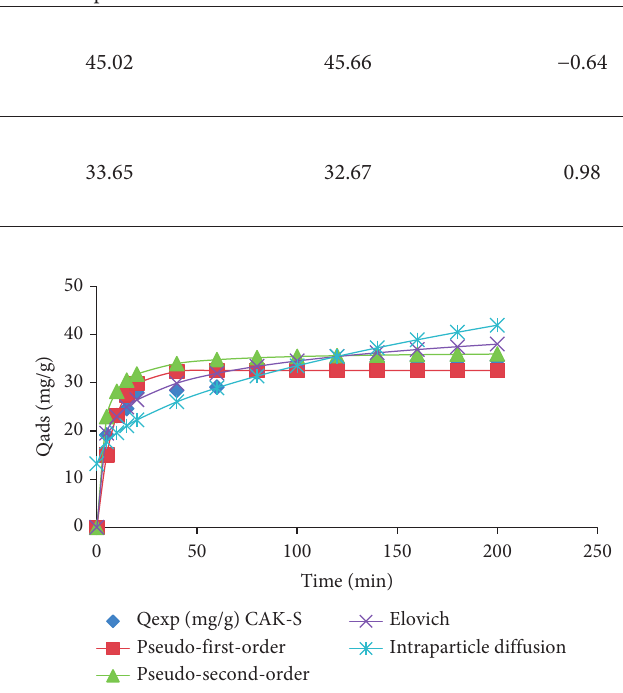
Table 7: Validation of the experimental model of the adsorption of HQ and R by CAK-S. Adsorbates